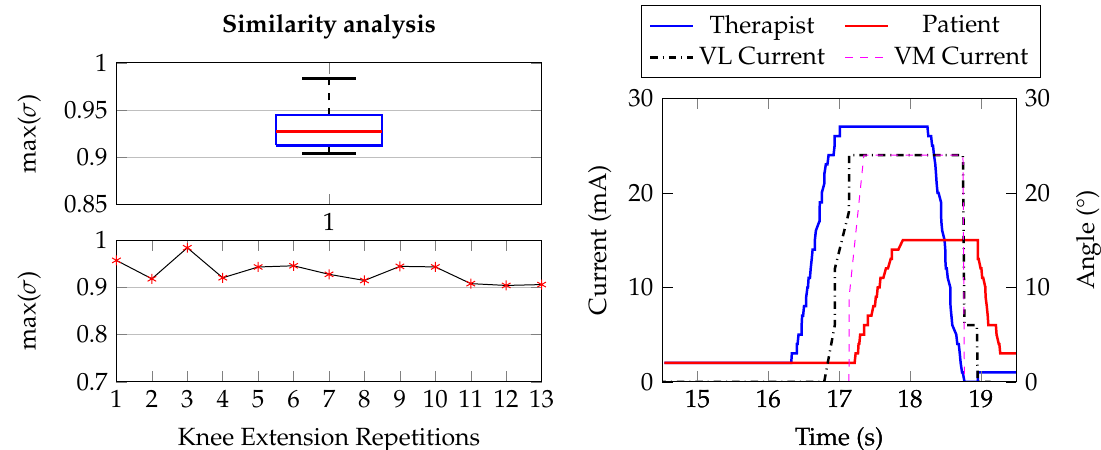
Figure 14. ( left ) Single repetition example showing the similarity between the two angular signals with respect to the vastus lateralis (VL) and vastus medialis (VM) stimulation currents. ( right ) Maximum of the cross-correlation coefficient for the 13 repetitions of the knee extension